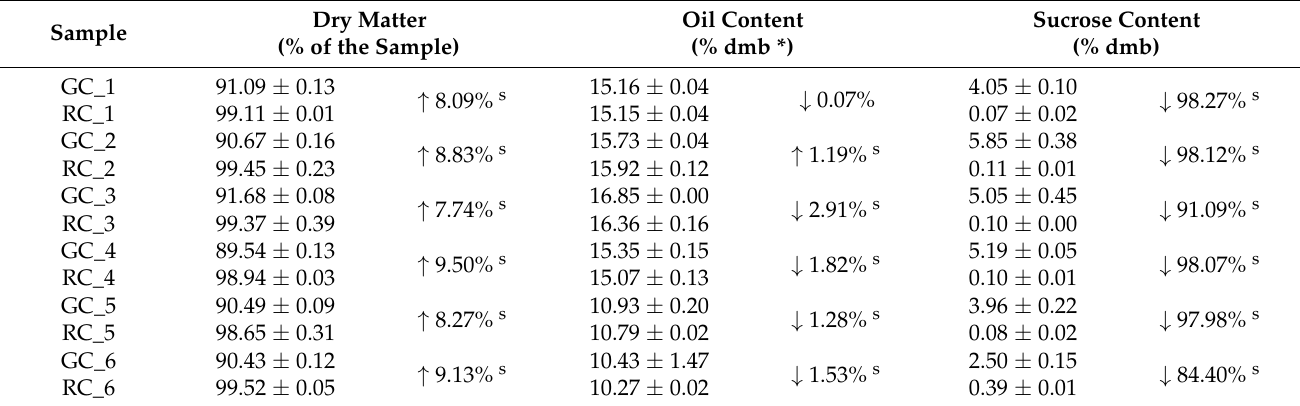
Table 3. Dry matter, oil and sucrose content in green (GC) and roasted (RC) coffee beans.